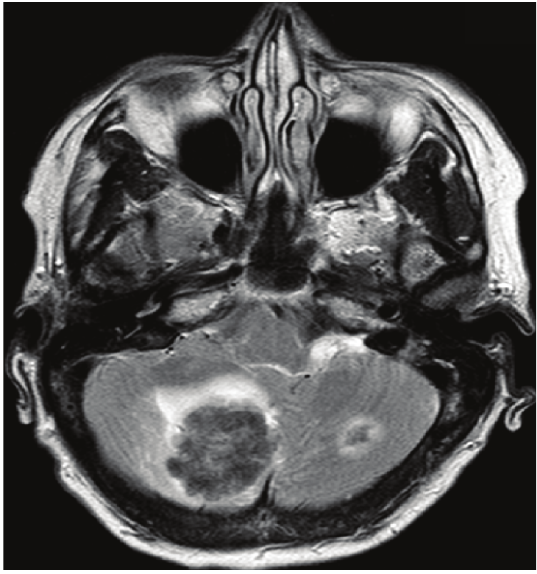
Figure 1: MRI of brain. Note space occupying lesions to cerebel-